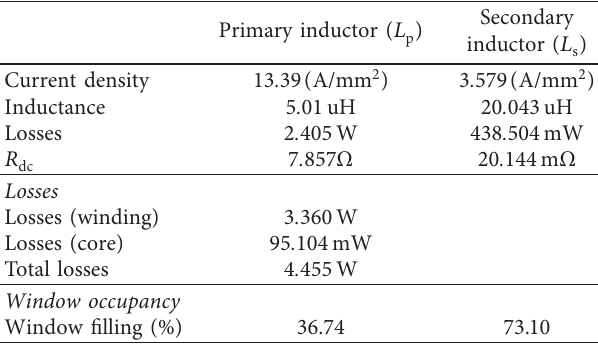
Table 2: Ansys Maxwell analysis report: coupled inductor per- formance results (DCM).